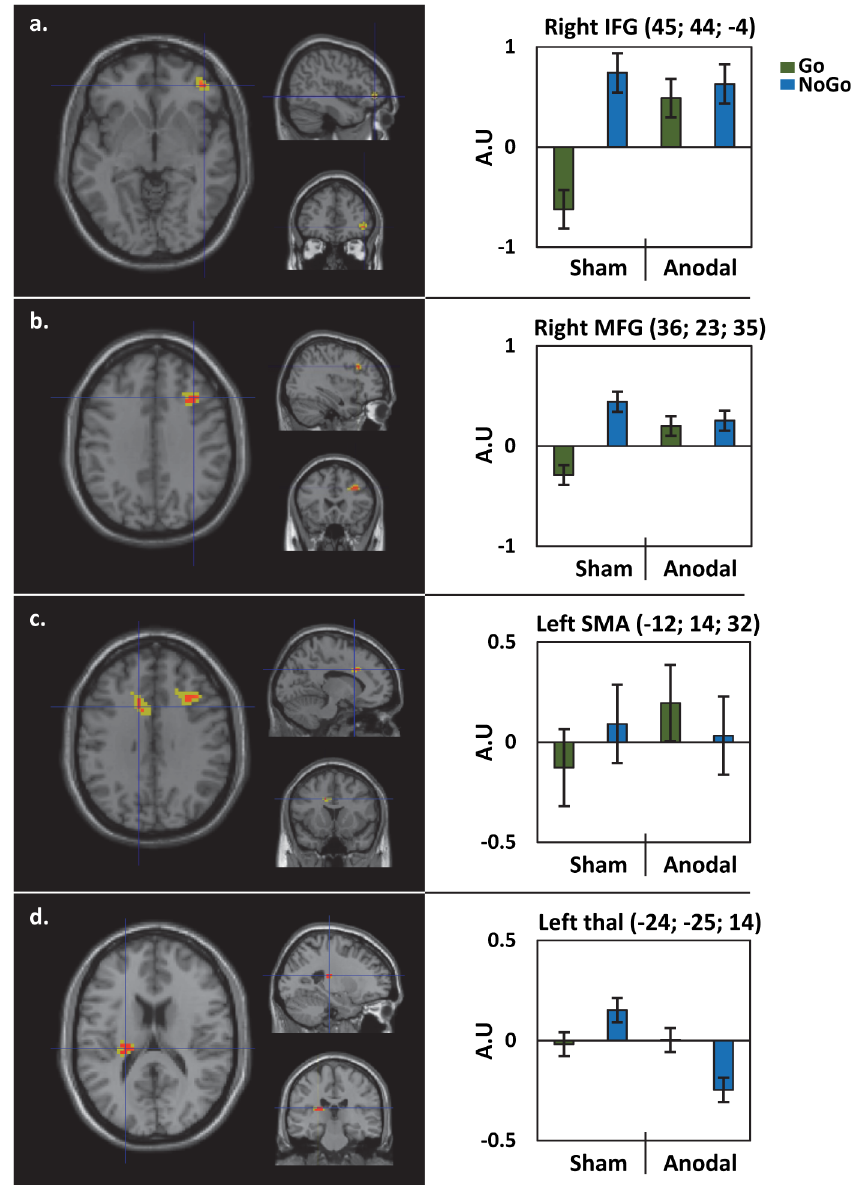
Fig 3. Functional neuroimaging results: Stimulation (Anodal; Sham) by Condition (Go; NoGo) Interaction. Results are shown on a normalized single-subject brain in the MNI space. Contrasts are represented at p FWE < 0.05 corrected at voxel level (min cluster size = 3, red) and to facilitate visualization p FWE < 0.3 in yellow). Histograms on the right indicate the amplitude of the effect (Arbitrary Unit: A.U) for each condition at clusters’ local maxima with standard error bars. MFG = middle frontal gyrus, IFG = inferior frontal gyrus, SMA = supplementary motor area (see supplementary materials for statistical details).